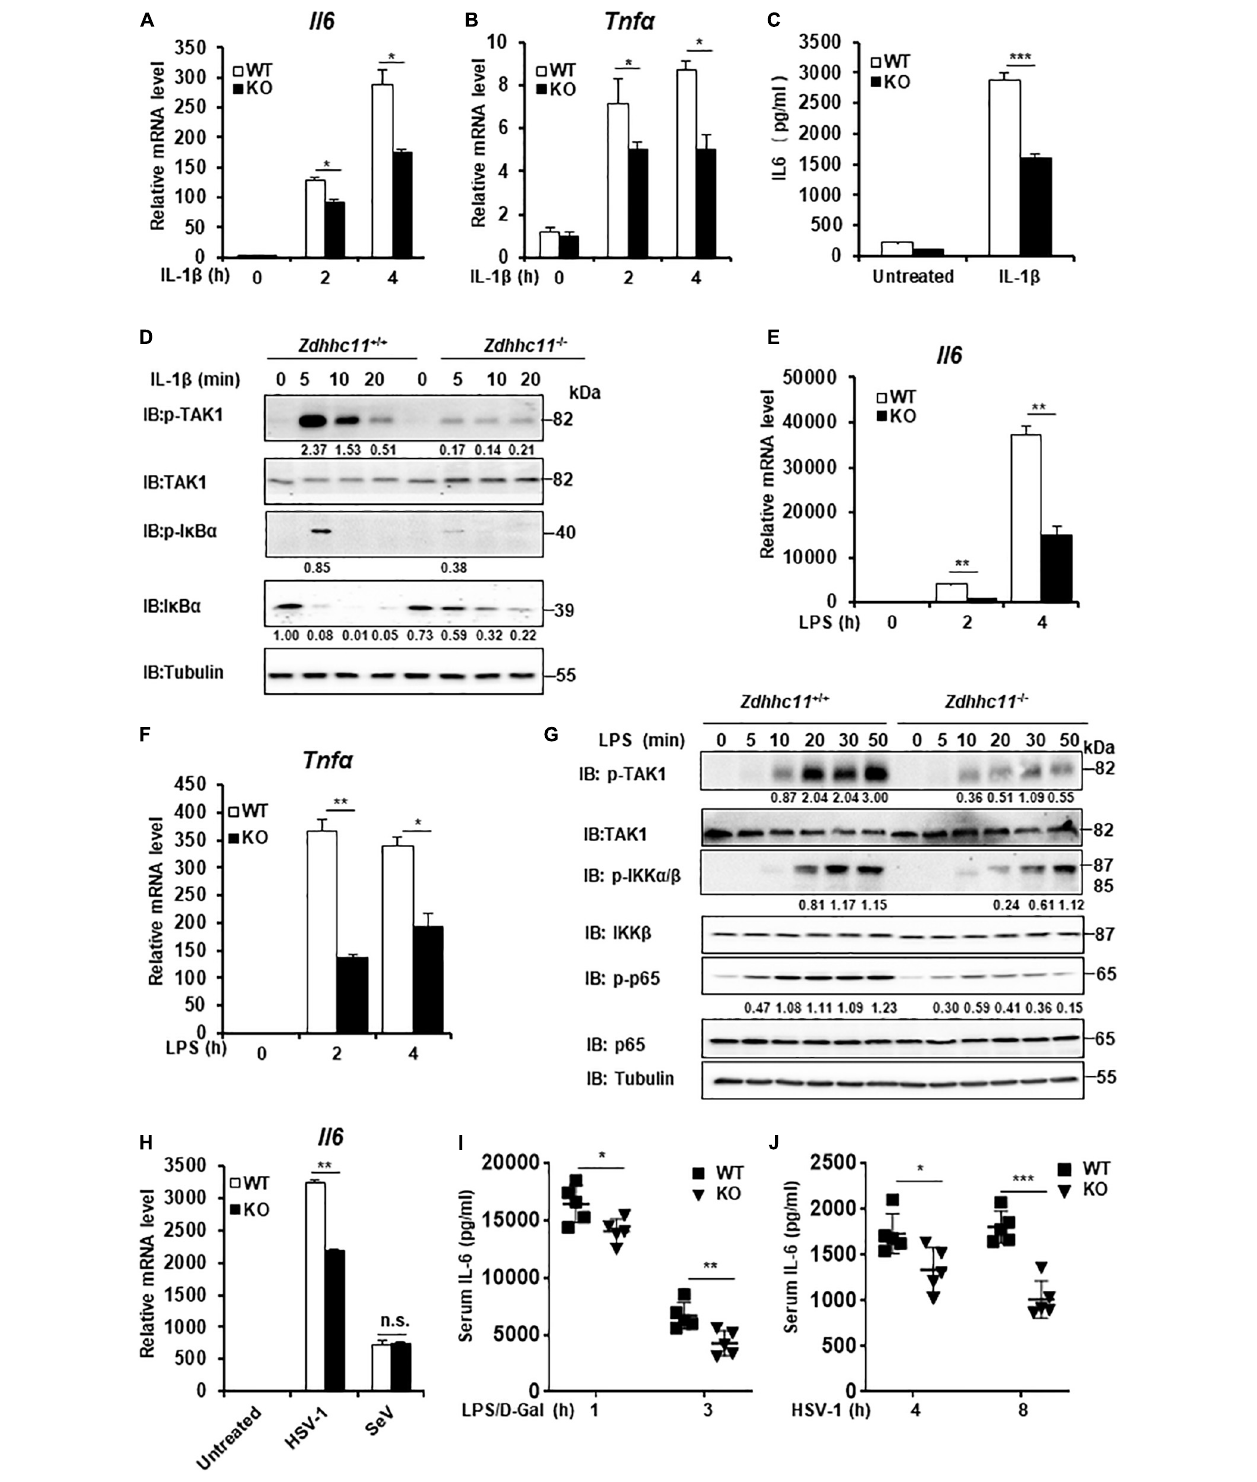
FIGURE 3 | Zdhhc11 deficiency reduces activation of NF- κ B stimulated by multiple stimuli. (A,B) Zdhhc11 + / + and Zdhhc11 − / − MEFs were stimulated with IL-1 β (20 ng/ml) for the time as indicated, then qRT-PCR assay was performed to measure transcriptional levels of Il6 (A) and Tnf α (B) . (C) Zdhhc11 + / + and Zdhhc11 − / − MEFs were stimulated with IL-1 β (2 ng/ml) for 18 h, followed by an ELISA Kit to measure IL6 in the culture supernatant. (D) Zdhhc11 + / + and Zdhhc11 − / − MEFs